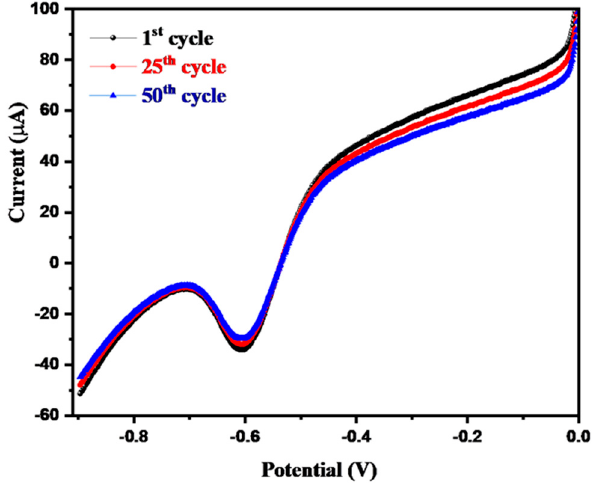
Figure 12. The LSV curves (1 st , 25 th , and 50 th cycle) of N-rGO/SPCE in the presence of 0.05 mM H 2 O 2 in 0.1 M PBS of pH 7.0 at a scan rate of mVs − 1 .